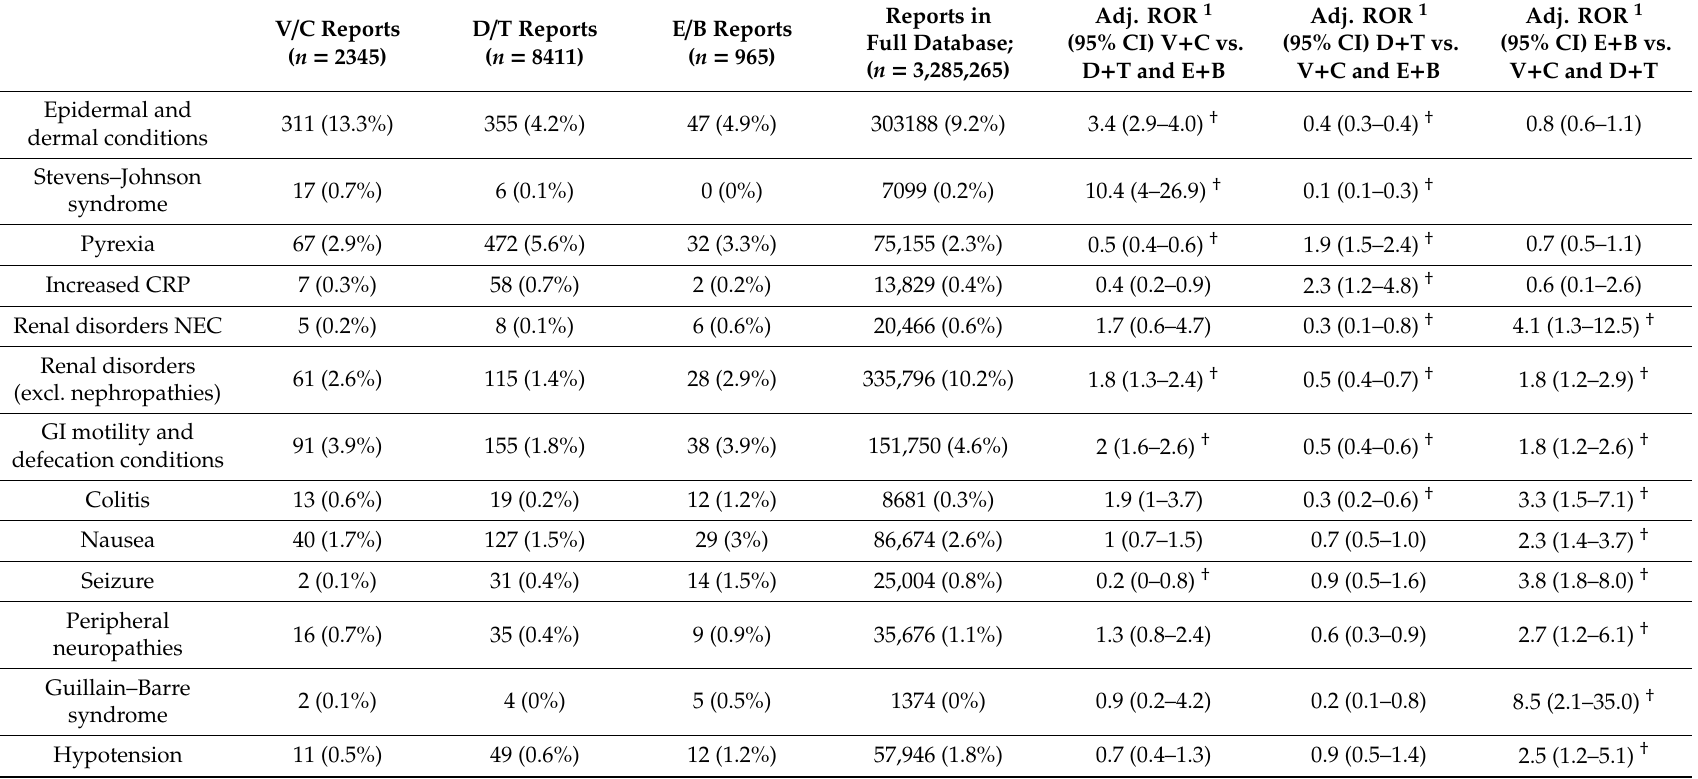
Table 2. Age-adjusted reporting odds ratio for selected serious adverse